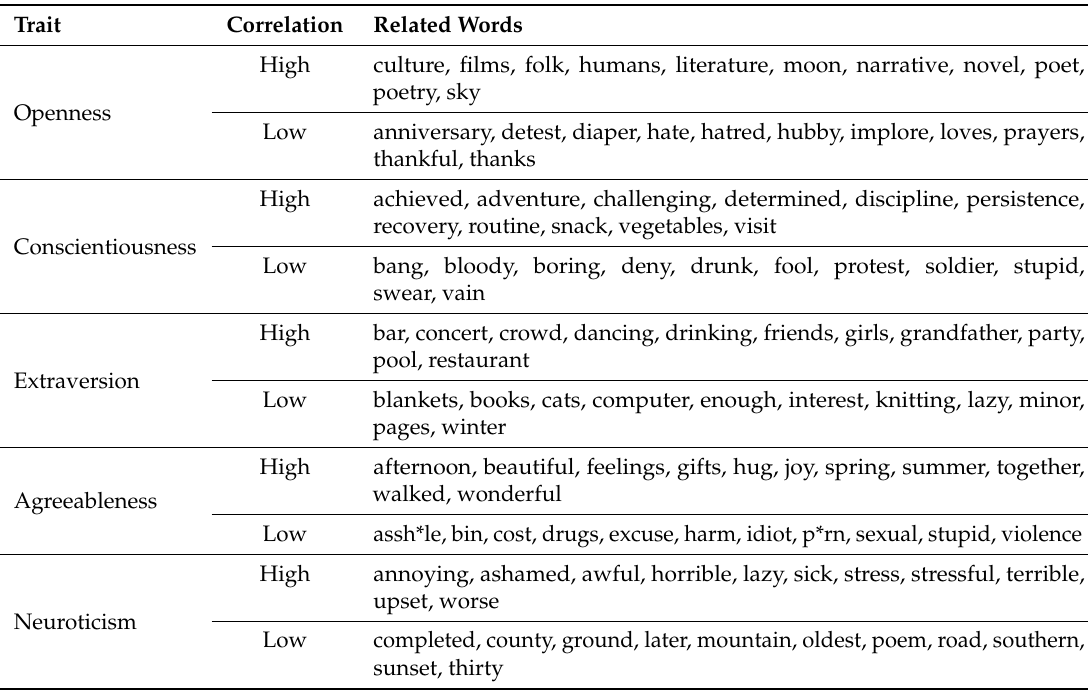
Table 1. List of words highly related to each personality trait, randomly selected from those reported in Yarkoni